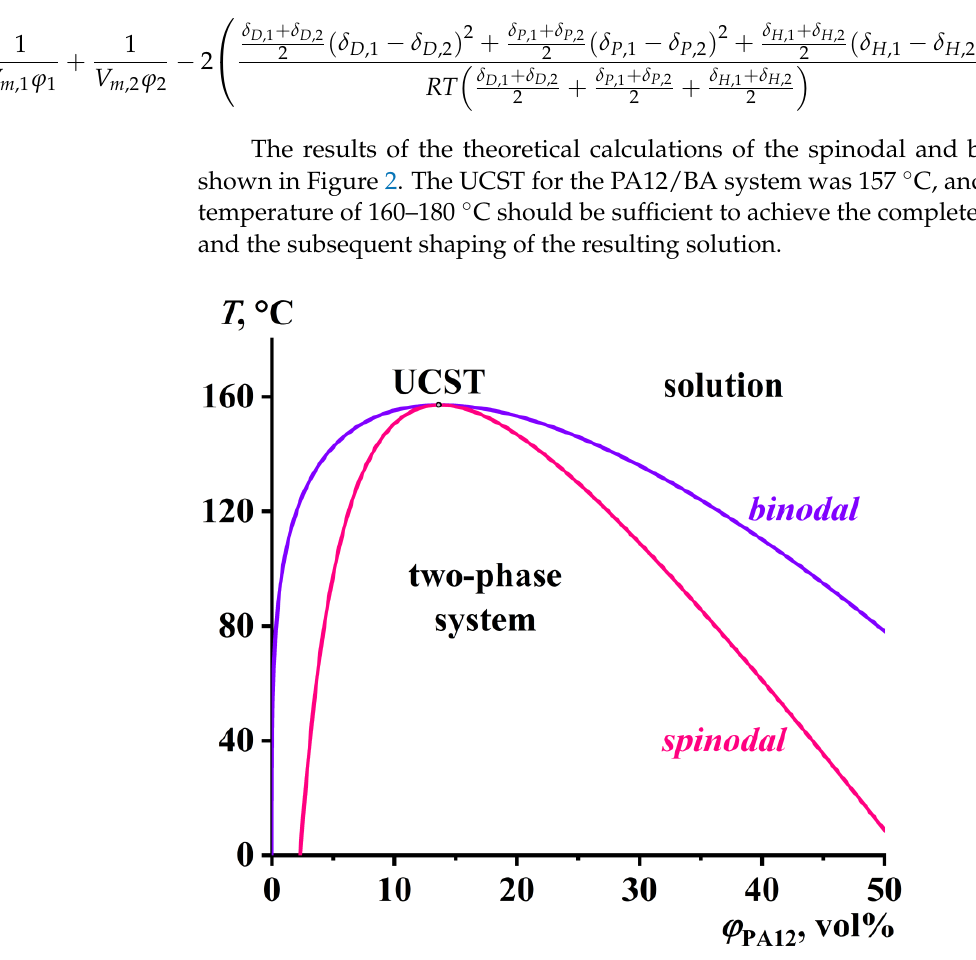
Figure 2. Phase diagram for a mixture of polylaurolactam and benzyl alcohol.